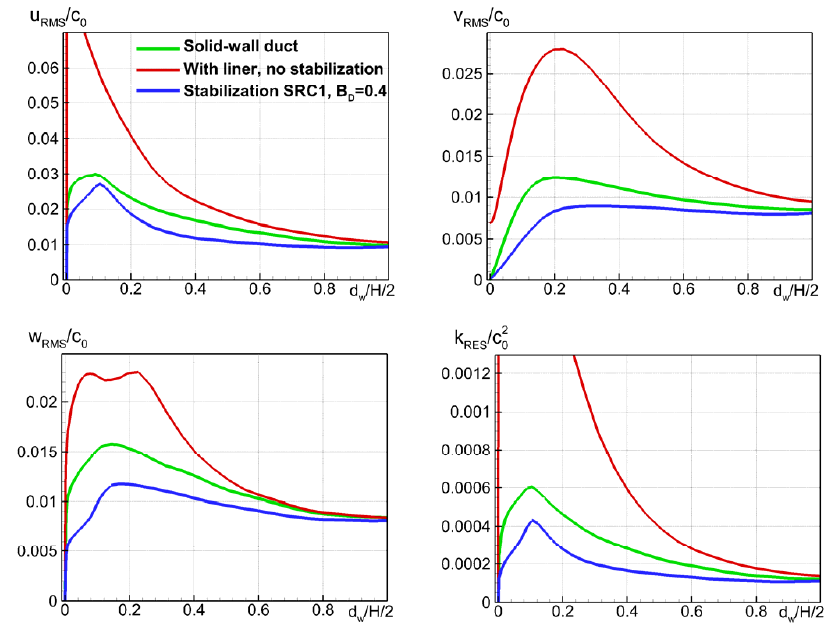
Figure 12. Comparison of wall-normal profiles of root-mean-square pulsations of velocity compo- nents and resolved TKE at x = 0.6 m predicted by the three WMLES.